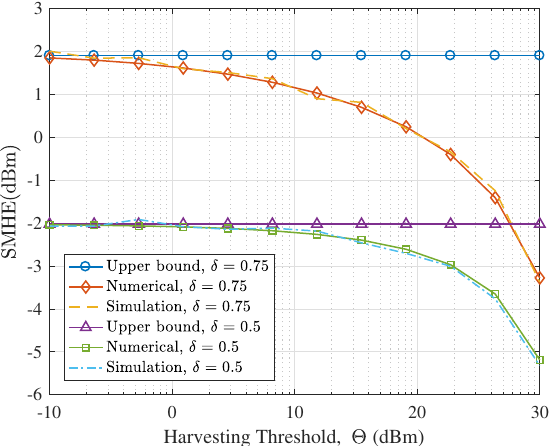
Figure 7. Spatial mean harvestable energy for LSWN-IC with λ t = 0.0001, α = 4, η a = 1 and P et = 30 dBm.